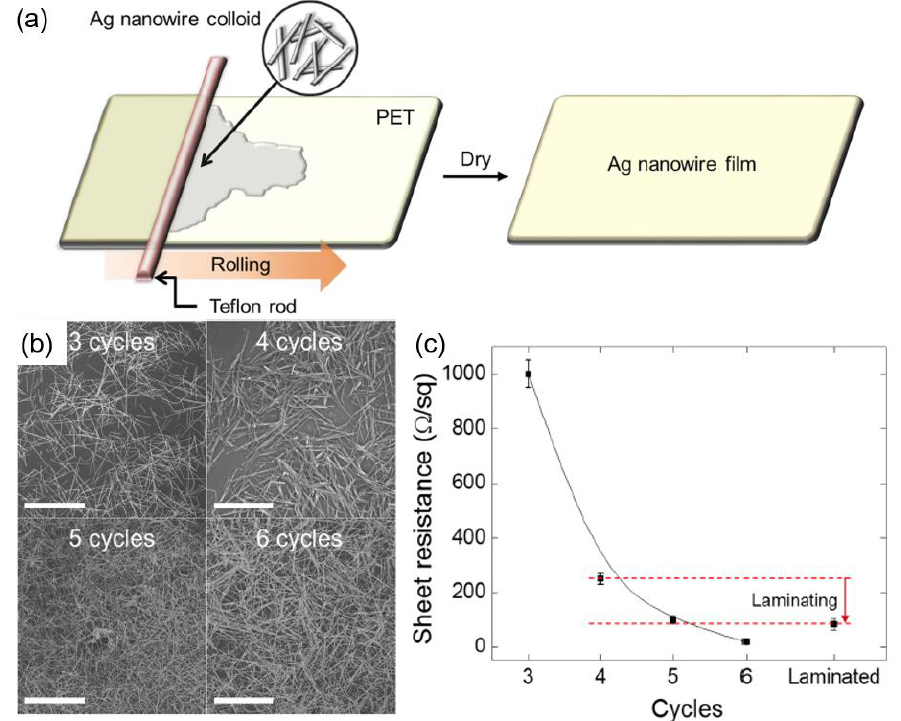
Figure 4. Schematic diagram of Ag NW network fabrication by bar-coating process. ( a ) Solution bar-coating of Ag NW network on a plastic (PET) substrate followed by a drying process. ( b ) SEM images of Ag NW network deposited at different cycle numbers. ( c ) Sheet resistance ( R s ) of Ag NW film as a function of coating cycle number [14].